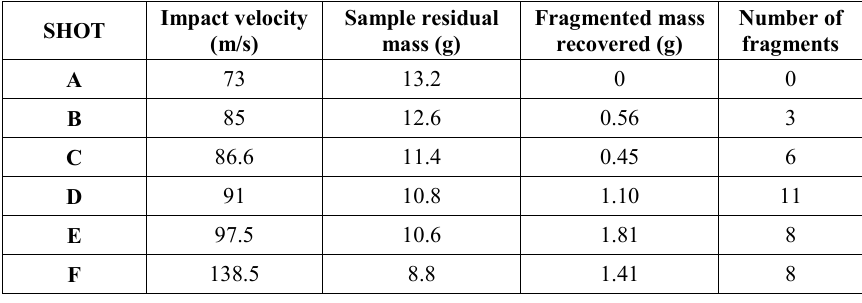
Table 1. Experimental outcomes: residual mass for samples at different impact velocities.